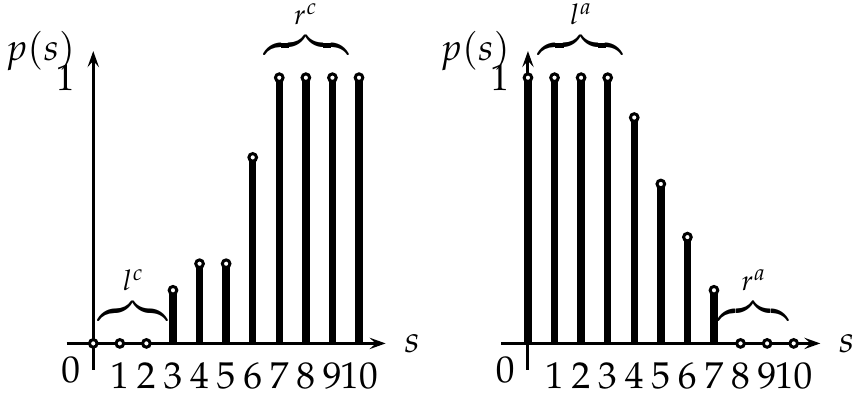
Figure 5. Aggregation functions when n = 10 for conformist ( left ) and anticonformist agent ( right ) (borrowed from [93])